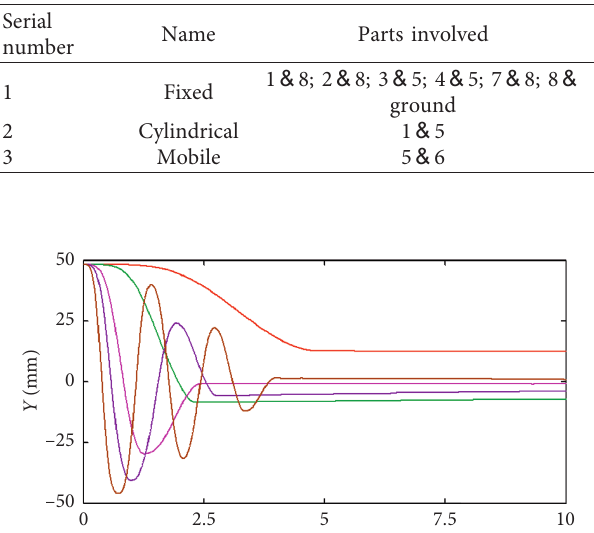
Figure 10: The dynamics simulation model of the gravity sensing mechanism. (1) Radial bearing; (2) axial thrust bearing; (3) filling material; (4) eccentric block; (5) mounting seat; (6) upper disc valve; (7) lower disc valve; (8) tool housing. Table 2: The gravity sensing mechanism dynamics simulation model motion pair settings.